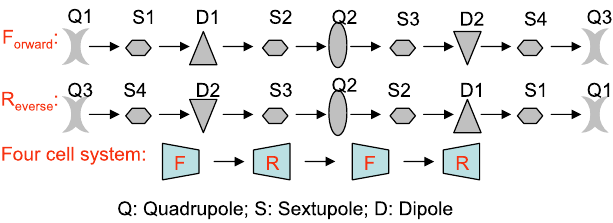
FIG. 11. (Color) Layout of the four cell bending system (FCBS). In total 33 magnets (8 dipoles, 9 quadrupoles, and 16 sextupoles) are used.